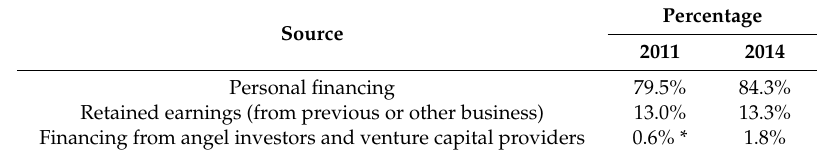
Table A3. Percentage of start-up firms that used di ff erent types of equity financing in Canada.